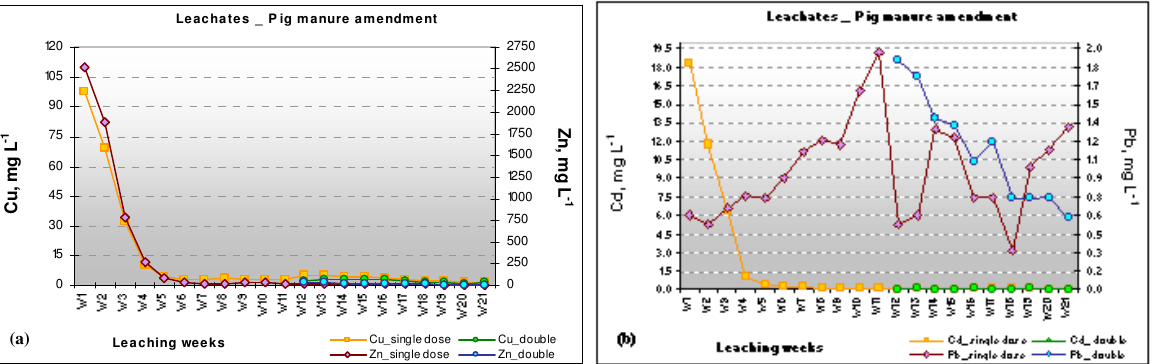
FIGURE 10. Evolution of metals concentrations in leachates: Cd-Pb (a) and Cu-Zn